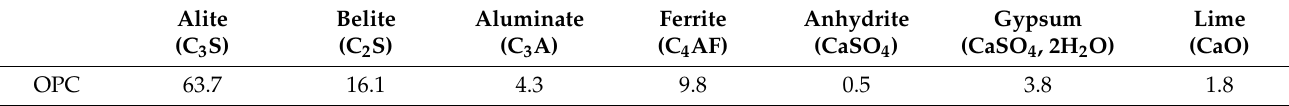
Table 4. Chemical composition of cement